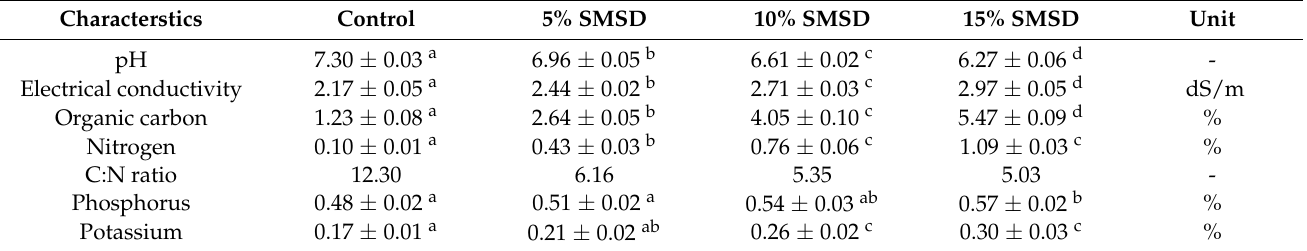
The same letters (a–d) indicate no significant difference among treatment group values at p <